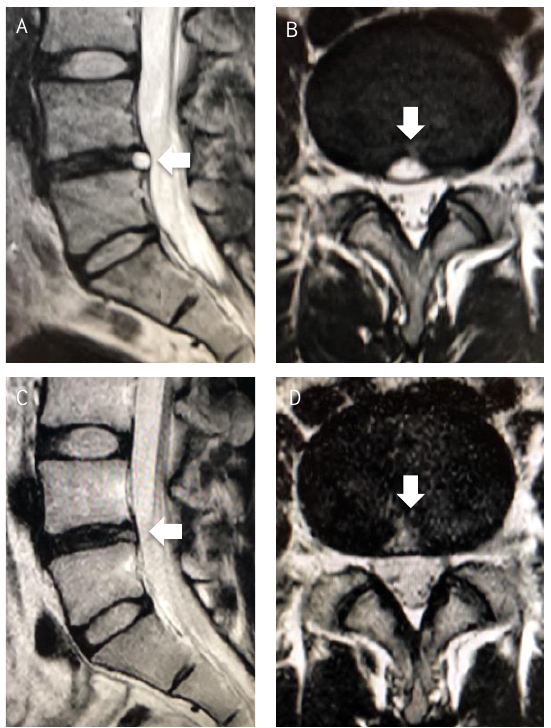
Figure 3. High-intensity zone (HIZ) on T2-weighted images (T2WI) (reused from [43]). Sagittal and axial T2WI of a 24 year old patient with a complaint of severe lower-back pain (LBP). ( A , B ) HIZ (white arrow) was observed in the midline of the posterior annulus fibrosus of the L4/5 disc. ( C , D ) Discoblock caused recurrent pain and temporary improvement of pain, and cauterization of the HIZ area under endoscopic view resolved LBP and showed improvement of the